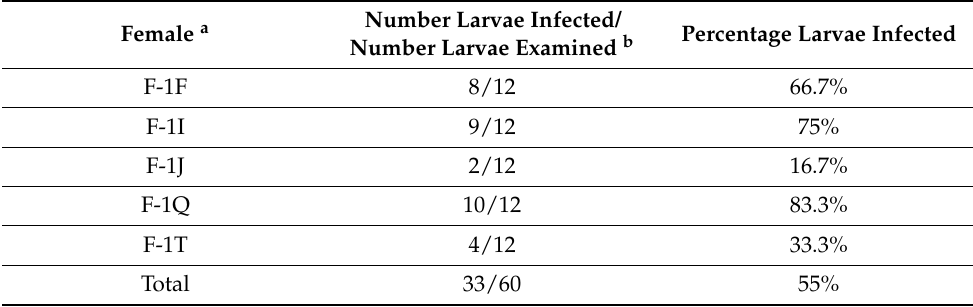
Table 6. Ornithodoros hermsi larvae infected with B. hermsii by transovarial transmission determined by immunofluorescence microscopy and staining for the variable tick protein